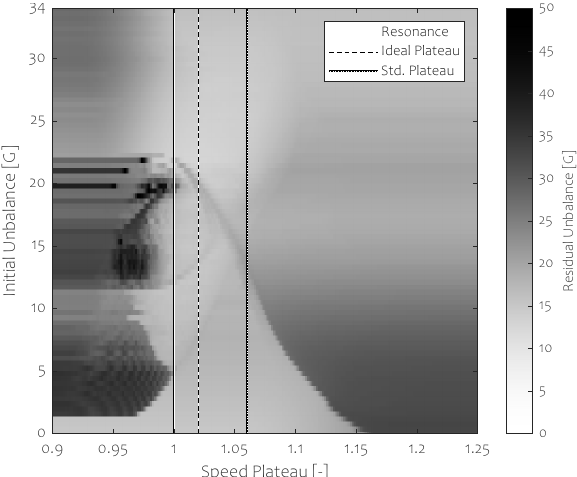
Figure 14. Effect of the initial unbalance on the valid lower speed plateau range, µ r = c r = 1. The ideal speed plateau is